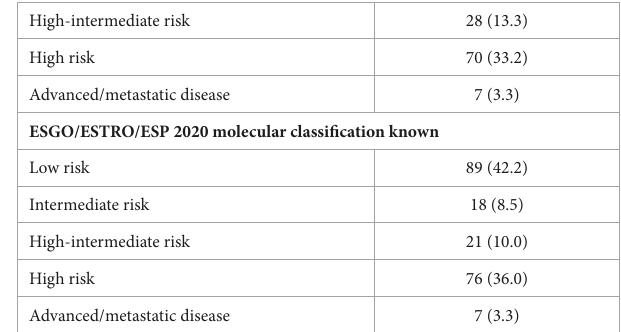
TABLE 1 Clinicopathologic characteristics of the study